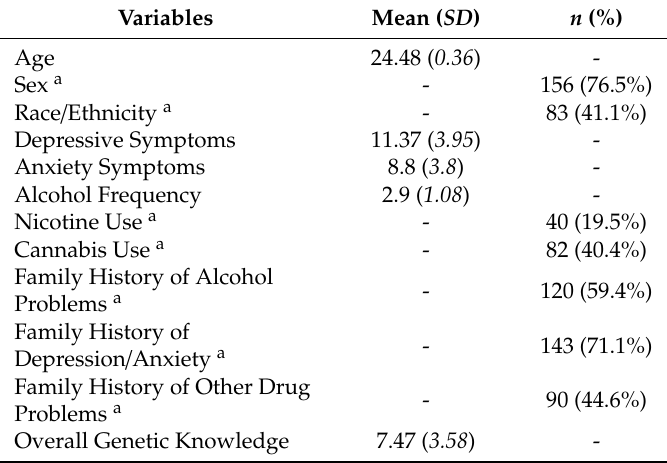
Table 3. Descriptives of study variables used to examine the relationship between demographic characteristics, substance use and mental health variables, and family history and individuals’ interest in receiving genetic